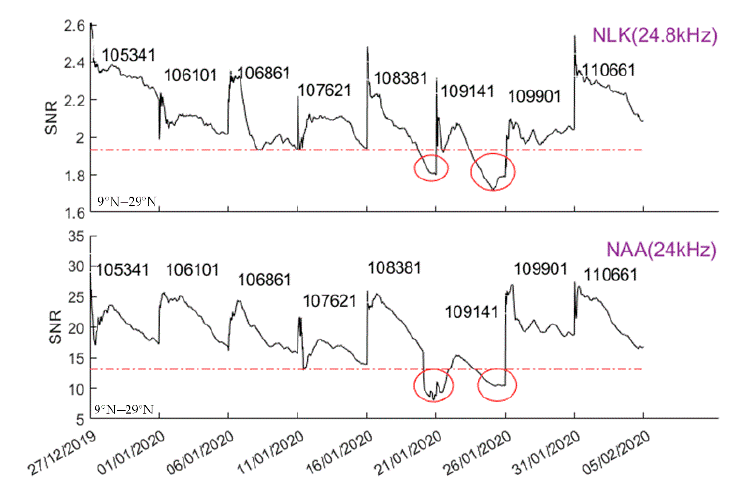
Figure 6. Orbit 108,381 and its revisited orbit SNR variation graph.